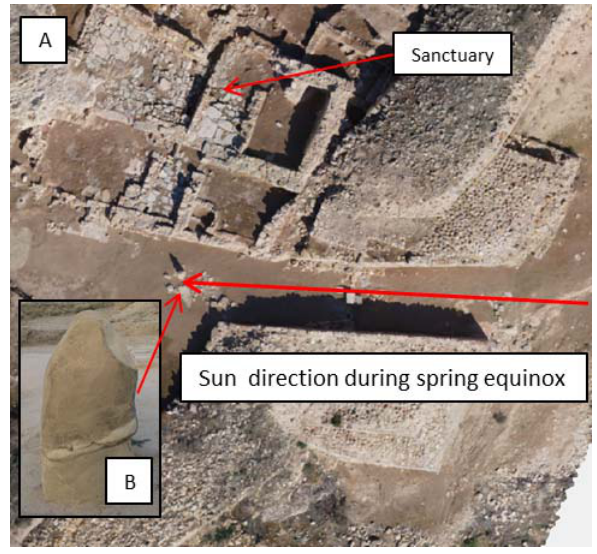
Figure 13. A: Orthoimage (1 cm resolution) of the Gate. The orientation of the Gate allows the sun’s ray hit an idol (B) interpreted as a goddess (Source: Ruiz and Molinos, 2015).